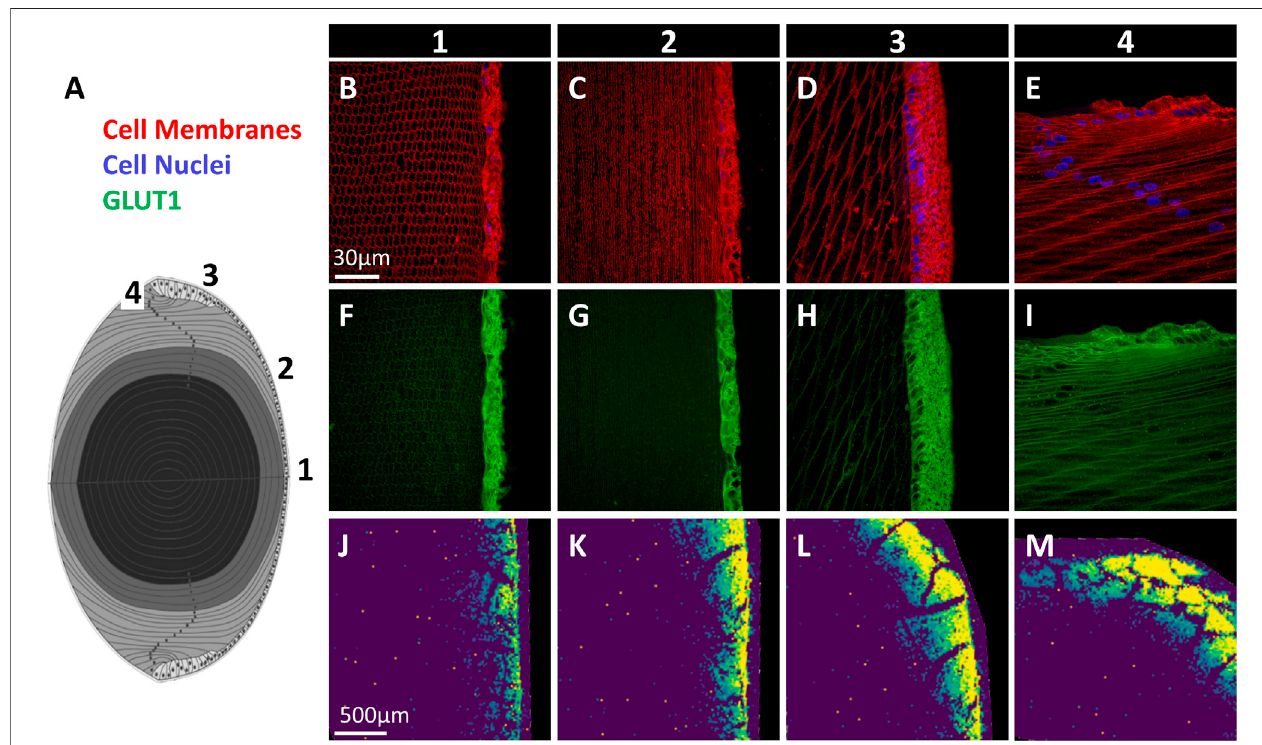
FIGURE 5 | Immuno fl uorescence mapping of GLUT1 in bovine lens. (A) Schematic diagram of lens axial section with locations of imaged regions indicated (1 – 4). (B – E) Cell membrane marker ( red ) and cell nuclei ( blue ) signal from marked regions in panel (A) show epithelial and fi bre cell morphology. (F – I) GLUT1 immunolabelling fromcorrespondingregions. (J – M) MALDIimagesofSILglucose( m/z 221.0528)uptakeinbovinelensesindicatingtheextentofSILglucoseuptakemediatedbyGLUTs in each